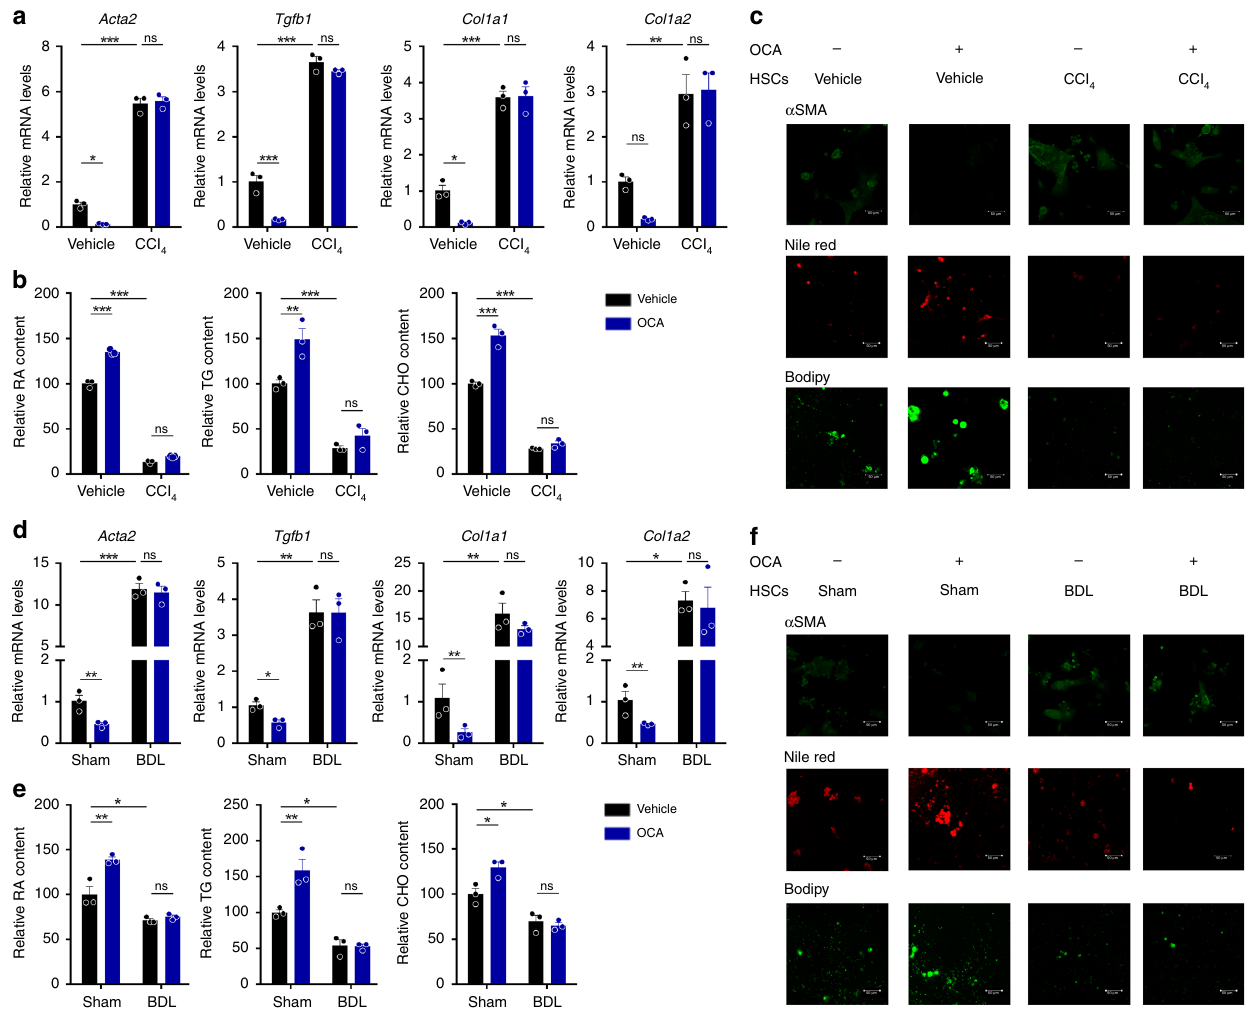
Fig. 3 OCA is ineffective against already activated HSCs. Effect of OCA on HSC activation were compared between quiescent and activated HSCs, caused by CCl 4 treatment a – c or BDL operation d – f . Freshly isolated HSCs were treated with OCA starting 1 day after seeding and collected for analysis after 4 days in culture. a and d mRNA levels of Acta2 , Col1a1 , Col1a2 , and Tgfb1 mRNAs in primary HSCs. b and e Lipids quantitation. c and f α SMA, Bodipy and Nile red staining of HSCs, data are representative of n = 3 biological independent samples. Scale bar, 50 μ m. n = 3 biologically independent samples within these experiments. Results are mean ± SEM, * P < 0.05, ** P < 0.01, *** P < 0.001, and ns, statistically not signi fi cant, as assessed with